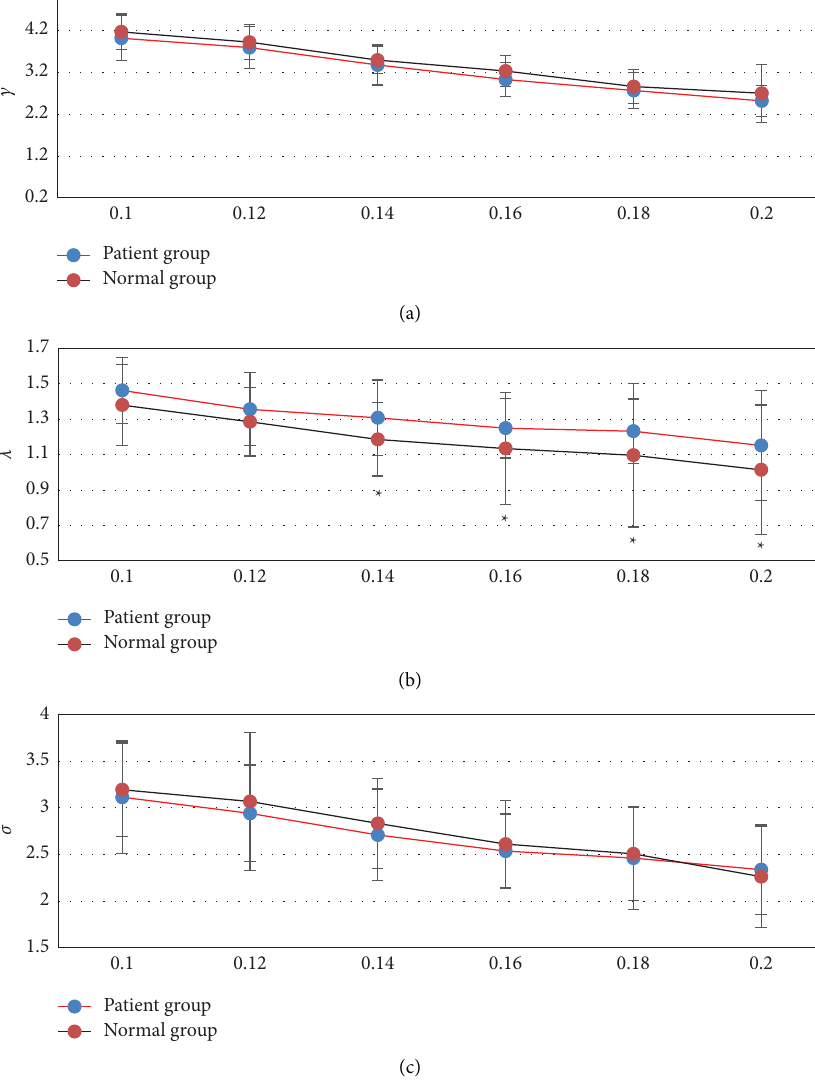
Figure 2: Comparison of fMRI parameters c , λ , and σ between the two groups. (a–c) represented c , λ , and σ , respectively. ∗ Compared with the normal group, P < 0 . 05.